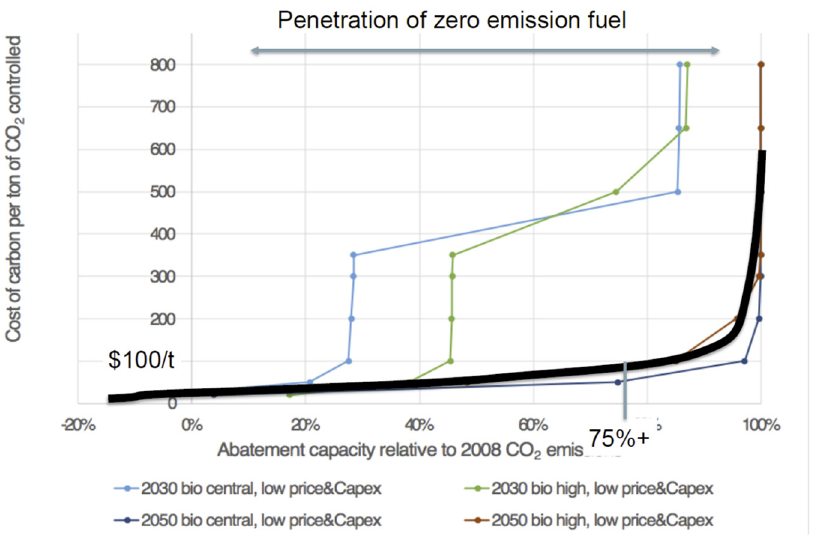
Figure 9. Unit cost of reducing emissions with a low renewable fuel price. Source: [35].